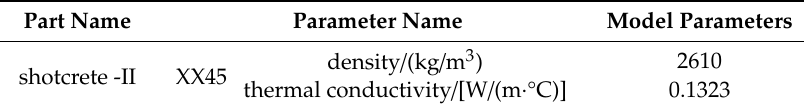
Table 15. Parameter table of test specimen XX45.